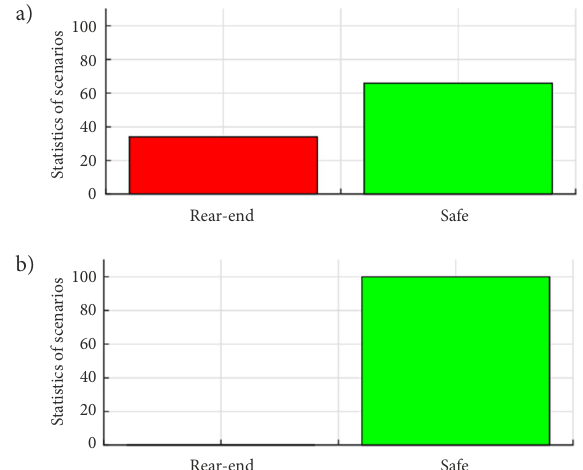
Figure 7. Statistics of the simulation scenarios (source: